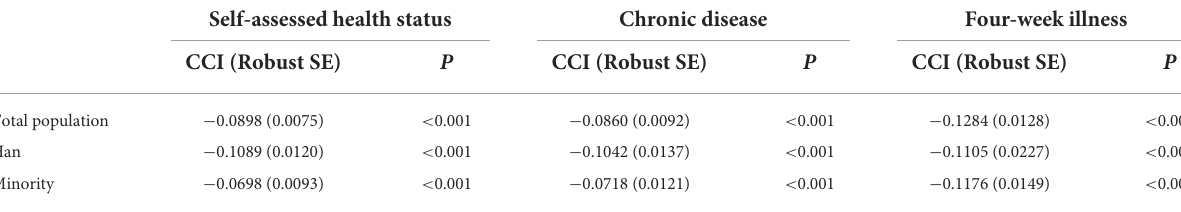
TABLE 2 Concentration index for health status of Chinese western rural adults in 2014 ( N =